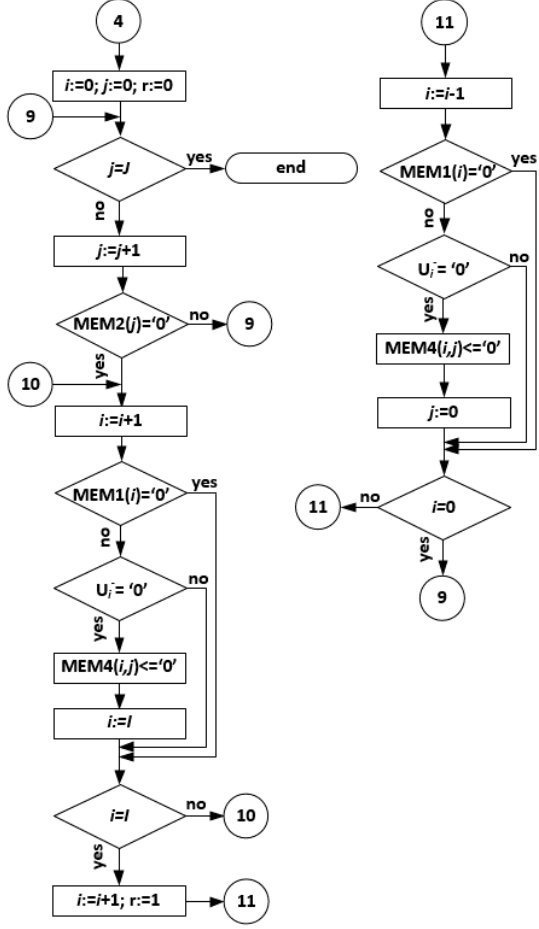
Figure 3. Operation algorithm of the surface defect monitoring system. Part II.